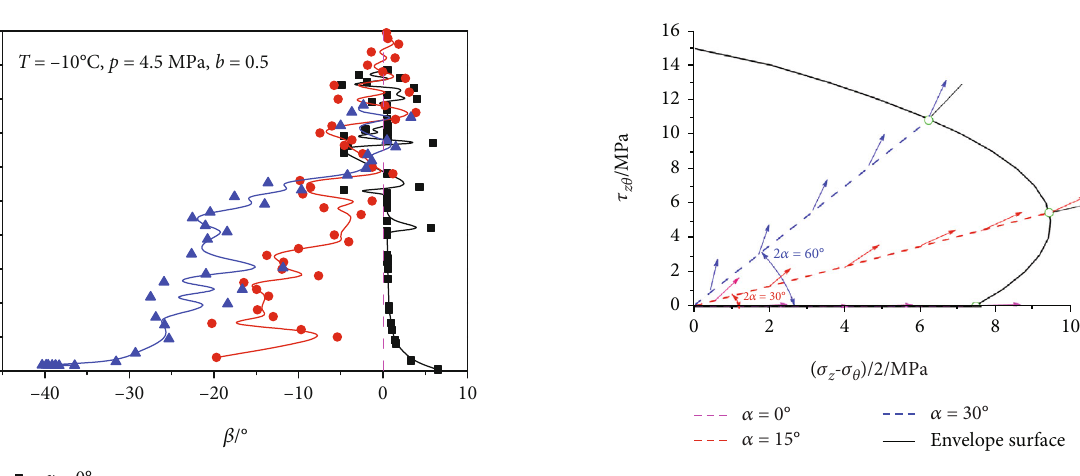
Figure 16: Direction of principal strain increment along di ff erent principal stress directions.